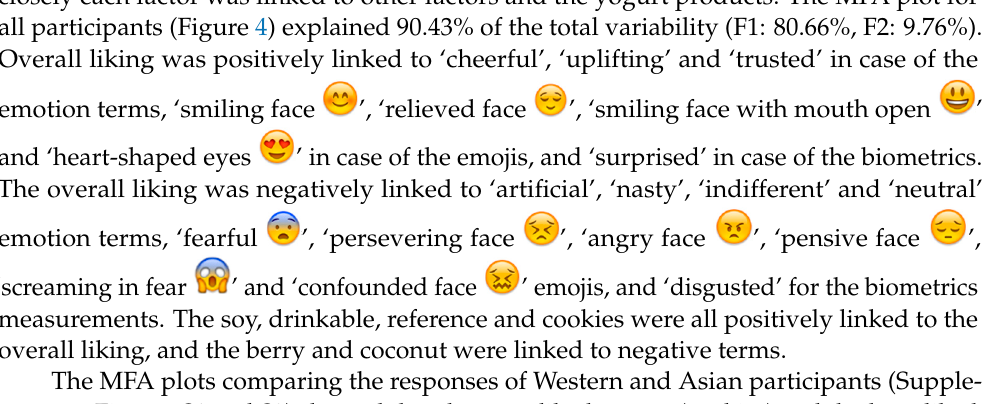
Table 3. Cochran’s Q test for emoji terms shown for the two cultural groups (Western consumers, Asian consumers) comparing terms within the culture, and using Fisher’s test to compare terms across cultures. ** Indicates significant differences between samples according to Cochran’s Q test at p < 0.001. * Indicates significant differences between samples according to Cochran’s Q test at p < 0.05. ns Indicates no significant difference between samples according to Cochran’s Q test at p > 0.05, with ‘a’ the largest in case of Western and ‘x’ in case of Asian consumers. Signifi ‐ cant differences between pairs of samples according to Fisher’s exact test are indicated by bold terms. Fisher’s exact test is generally more conservative than Cochran’s Q test, so the paired comparisons may all be not significant even if the overall test is significant.